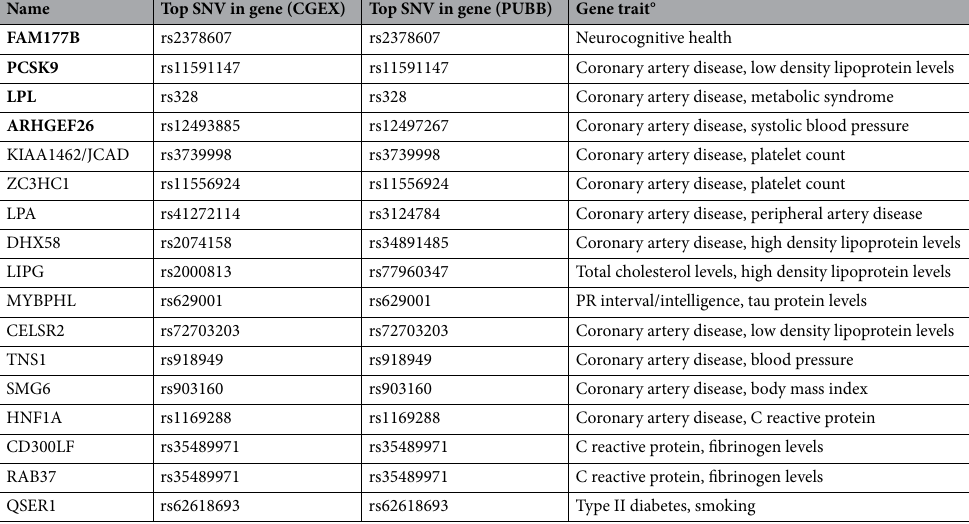
Table 3. Top 17 enriched genes identified in both GBA methods across CARDIoGRAM (CGEX) and Pan UK Biobank (PUBB). Genes highlighted in bold with p values less than the Bonferroni-corrected significance threshold (p ≤ 3 × 10 –6 ) in both CGEX and PUBB GWAS. °Gene trait: clinical phenotypes (maximum 2) obtained using the GWAS catalog (https:// www. ebi. ac. uk/ gwas/ genes), the Ensembl genome database (https:// www. ensem bl. org), the National Center for Biotechnology ClinVar web-based database (https:// www. ncbi. nlm. nih. gov/ clinv ar/ varia tion/), and through pubmed search (https:// pubmed. ncbi. nlm. nih.